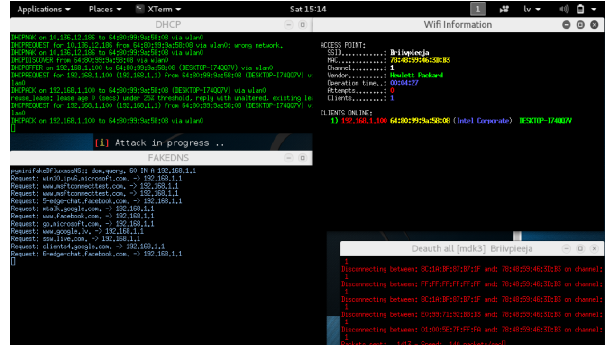
Fig. 8. Screenshot of the program Fluxion hosting a malicous wireless access point, sending deauthorisation frames in the real “Briivpieeja” network and forwarding all trafiic sent in the malicious network to the phishing site.